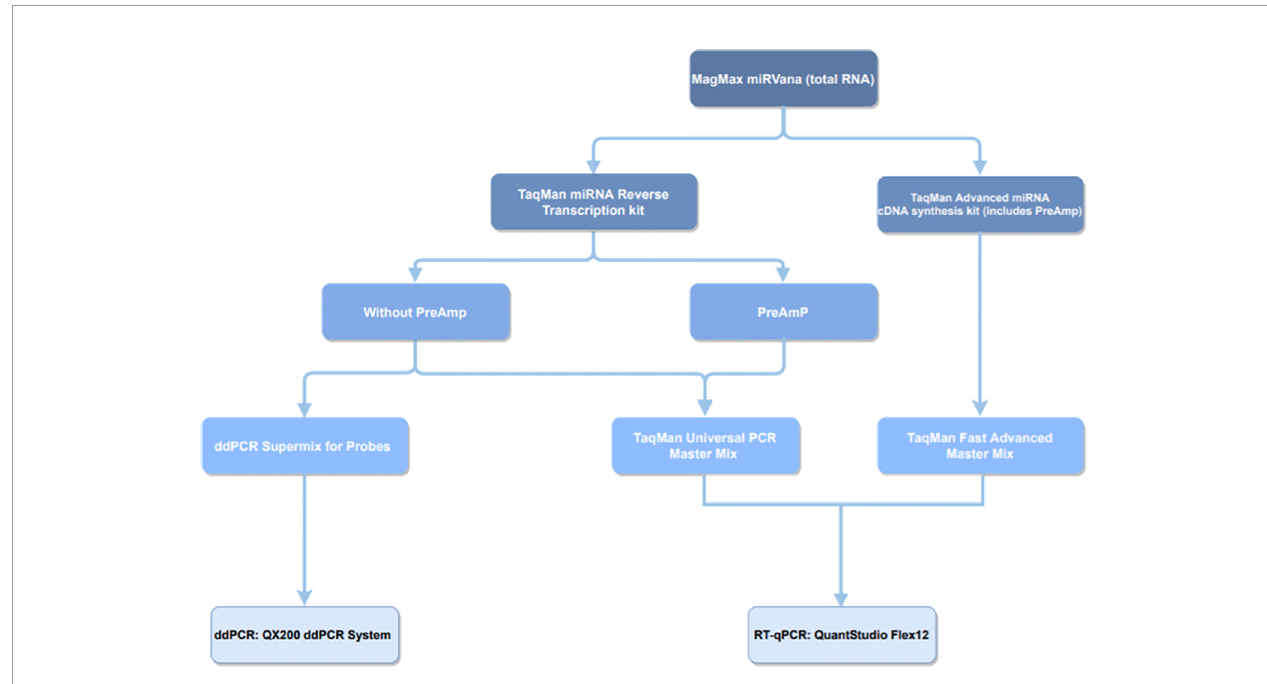
FIGURE 1 | Diagram of the study protocol, including RT-qPCR and ddPCR pipelines. ddPCR, droplet digital PCR; preamp, preampli fi cation; RT-qPCR, real-time quantitative